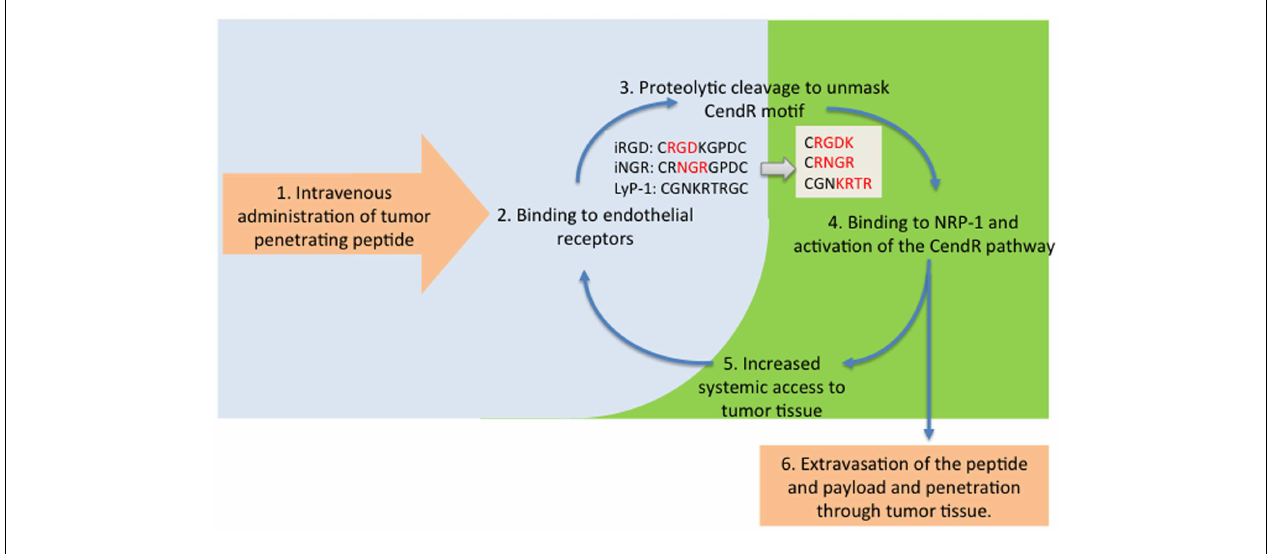
triggers extravasation of the processed peptide and payload and triggers a bulk transport process that increases delivery of payloads (6) and systemic accessibility of blood-borne compounds, including unprocessesed tumor-penetrating peptides for progressive penetration into tumor tissue (5).